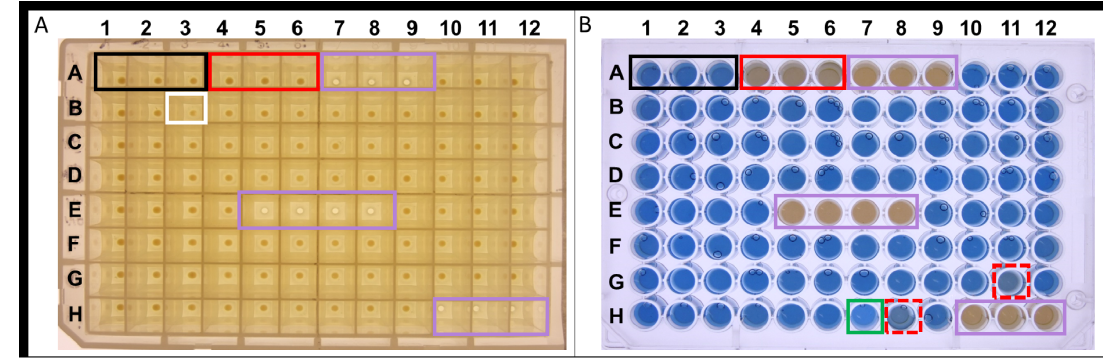
Fig 3. Representative photographs of exoprotein assessment in a 96-well master plate. (A) Inoculation plate post-centrifugation at 16 hpi on a lightbox. Wells A1–3 (black box) contain MH96 (wild-type); A4–6 (red box) contain K18 (non-secretion control); A7–9, E5–8, and H10–12 (purple box) contain LB broth blanks. The pellet sizes of the strains were compared with those of MH96 (black box) and mutant strains with smaller cell pellets were identified (white box). LB-only blanks (purple boxes). (B) Bradford protein assay of supernatants from 96-well master plate shown in panel A. No color change was observed for strain K18 (non-secreting control, red box with solid lines). Transposon mutants with decreased (red boxes with dashed lines) and increased (green box) exoprotein compared to the wild type (black boxes) are indicated.